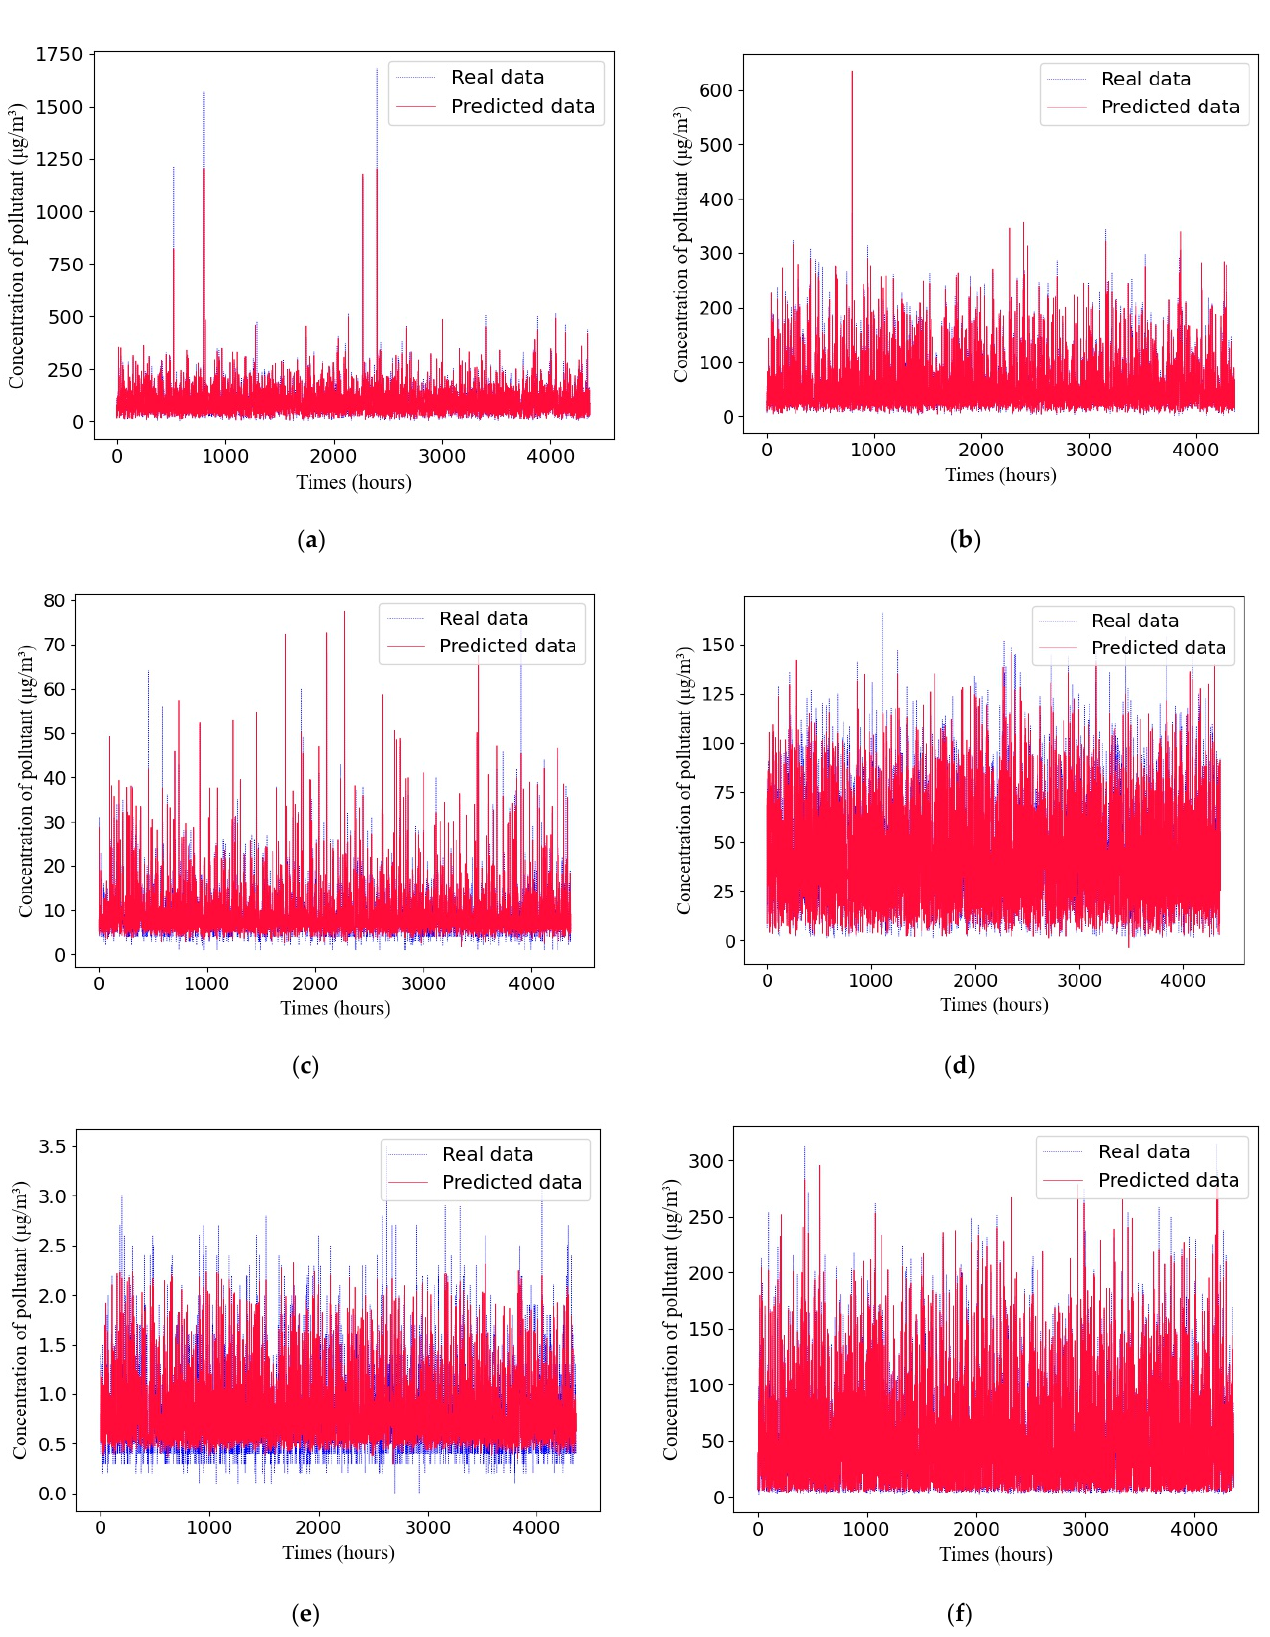
Figure 9. Comparison of the predicted values and real values of different pollutants with the GRU network in Dataset 3: ( a ) PM 10 ; ( b ) PM 2.5 ; ( c ) SO 2 ; ( d ) NO 2 ; ( e ) CO; ( f ) O 3 .